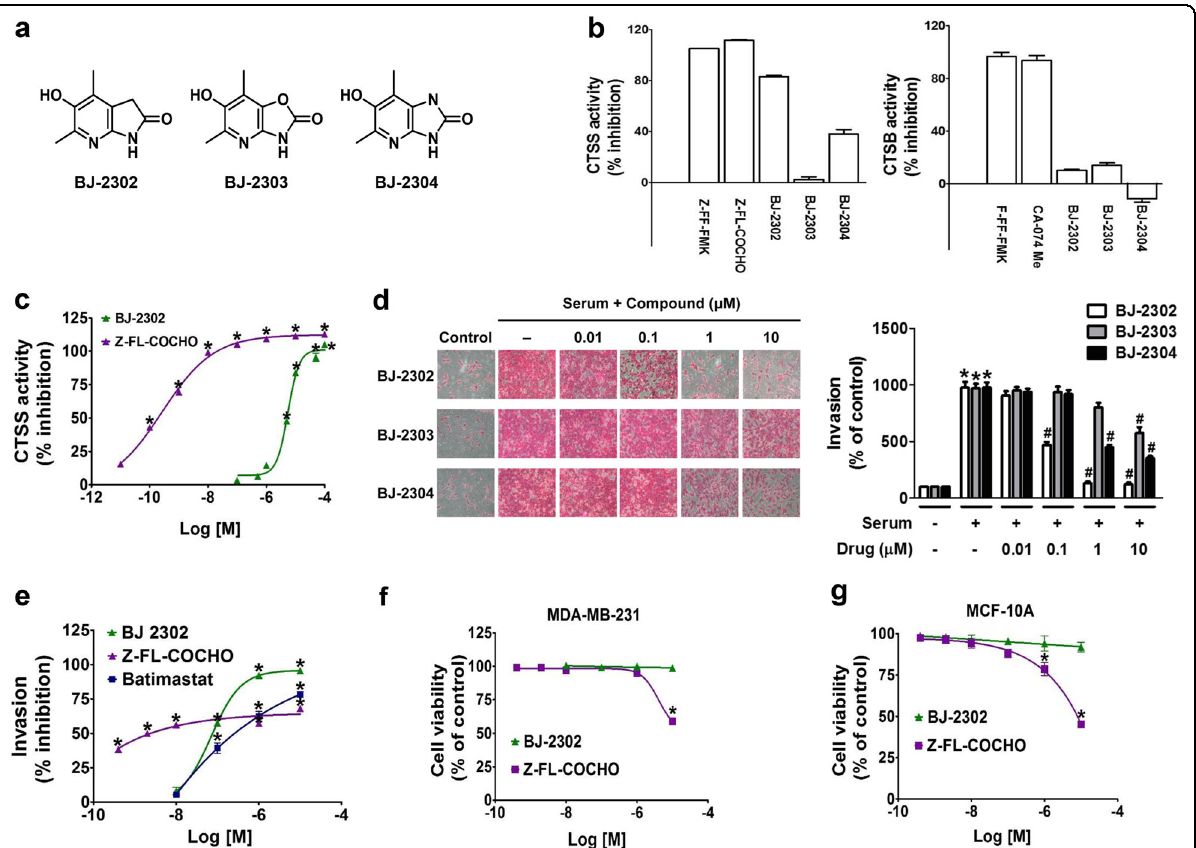
Fig. 3 Effects of bicyclic aminopyridinol compounds on CTSS activity, invasion, and viability of MDA-MB-231 cells. a Chemical structure of three bicyclic aminopyridinol compounds, BJ-2302, BJ-2303, and BJ-2304. b , c Inhibitory effects of the three compounds on CTSS and CTSB activity. * P < 0.05 compared to vehicle-treated controls. d MDA-MB-231 cells were pretreated with the compounds, and a serum-induced invasion assay was performed. The photos are representative of three independent experiments, and the bar-diagram represents the mean ± S.E.M. * P < 0.05 compared to vehicle-treated cells. # P < 0.05 compared to serum-treated cells. e Measurement of the IC 50 of serum-induced invasion of MDA-MB-231 cells treated with Z-FL-COCHO, batimastat, or BJ-2302. * P < 0.05 compared to serum-treated cells. f , g Effect of BJ-2302 or Z-FL-COCHO on the cell viability of MDA-MB-231 breast cancer cells ( f ) and MCF-10A normal breast cells ( g ). * P < 0.05 compared to vehicle-treated